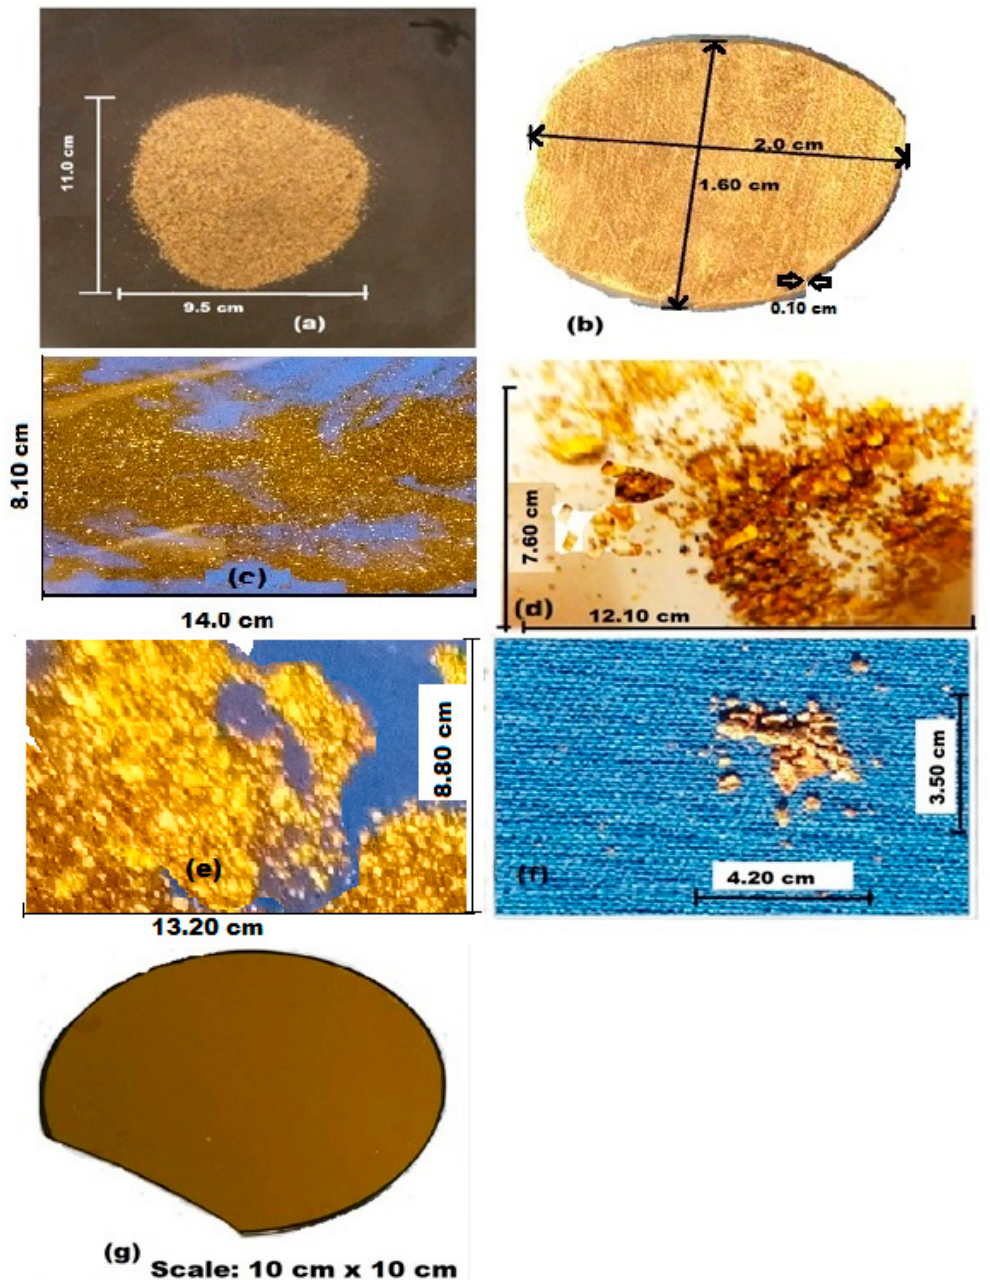
Figure 3. ( a ) Dry residual sample (tailing) from an artisanal mine site at Dunkwa-On-Offin. ( b ) Part of the sample refined into pure Au nugget of 1 gram and 22 carats (measured with a digital electronic Au purity Analyzer D H 300 K from VTSYIQ). ( c ) Panned sample of Au with other impurities, ( d ) untreated ore powder, ( e ) fine-grained concentrate Au, ( f ) coarse-grained concentrate powder, and ( g ) Au film on wafer substrate. (Photo by G.K. Nzulu).